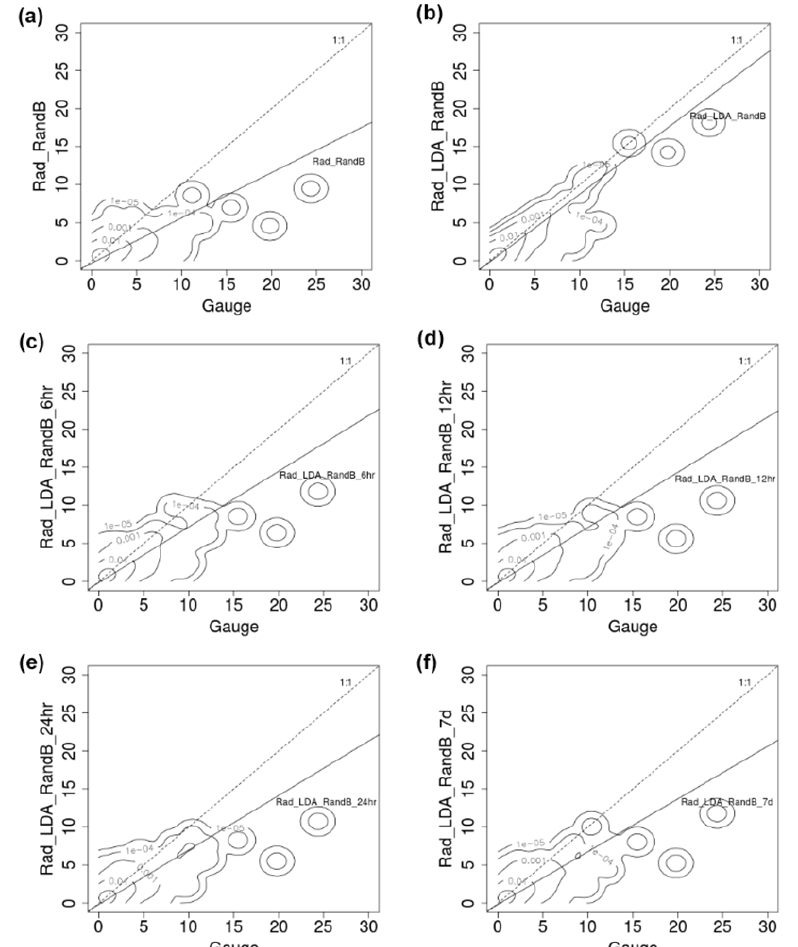
Figure 7. Impact of changing the integration time length, with verification for the independent gauges, using verification dataset (a) from sum- mer 2015. Accumulation plots with density isolines of hourly values in millimeters: (a) Rad_LDA_Accum (with regression line equation y = 0 . 594 x − 0 . 312), (b) Rad_LDA_RandB ( y = 0 . 891 x − 0 . 147), (c) Rad_LDA_RandB_6hr ( y = 0 . 732 x − 0 . 160), (d) Rad_LDA_RandB_12hr ( y = 0 . 725 x − 0 . 169), (e) Rad_LDA_RandB_24hr ( y = 0 . 715 x − 0 . 167) and (f) Rad_LDA_RandB_7d ( y = 0 . 692 x − 0 . 166). The fit is shown in solid lines (see regression equations); the perfect solution would align on the 1:1 dashed line. Table 2. Impact of the integration time length on the RandB method for the dependent and independent stations datasets during